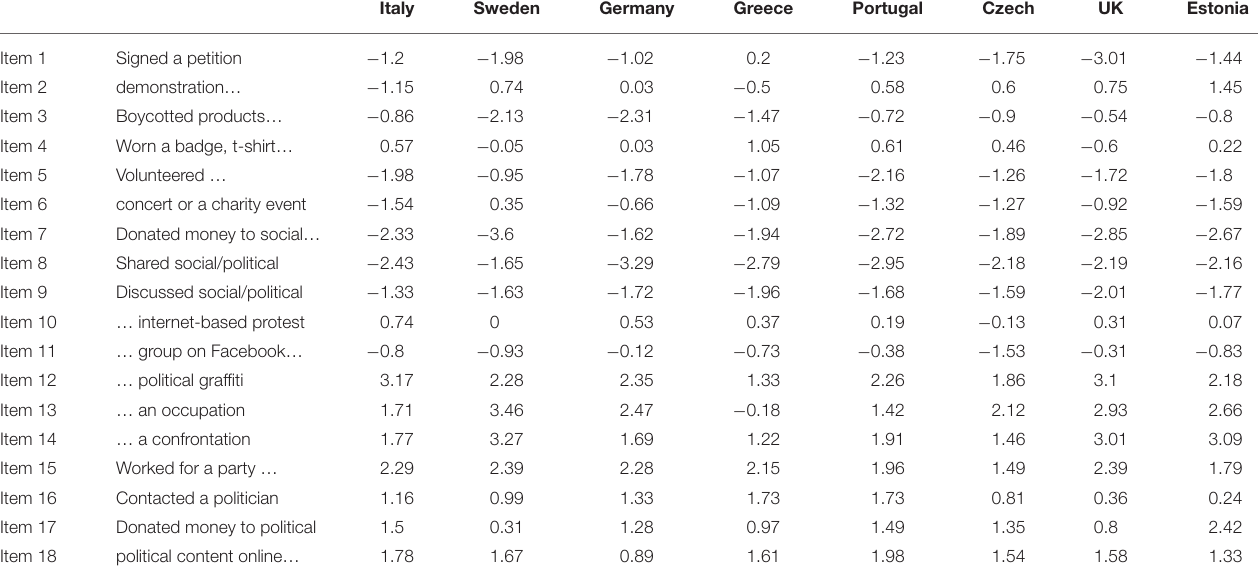
TABLE 9 | DIF based on